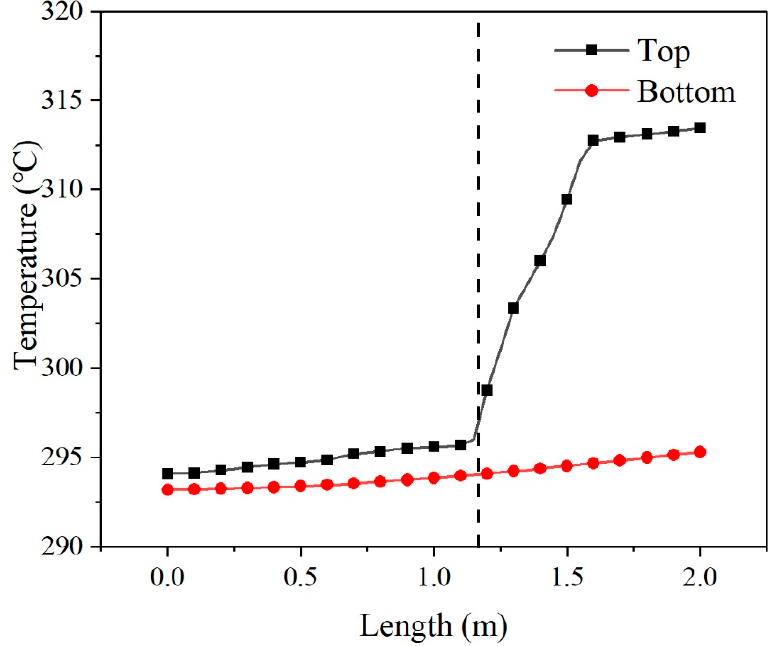
Figure 5. The temperature of the top and bottom fluid changes with the distance from the hot